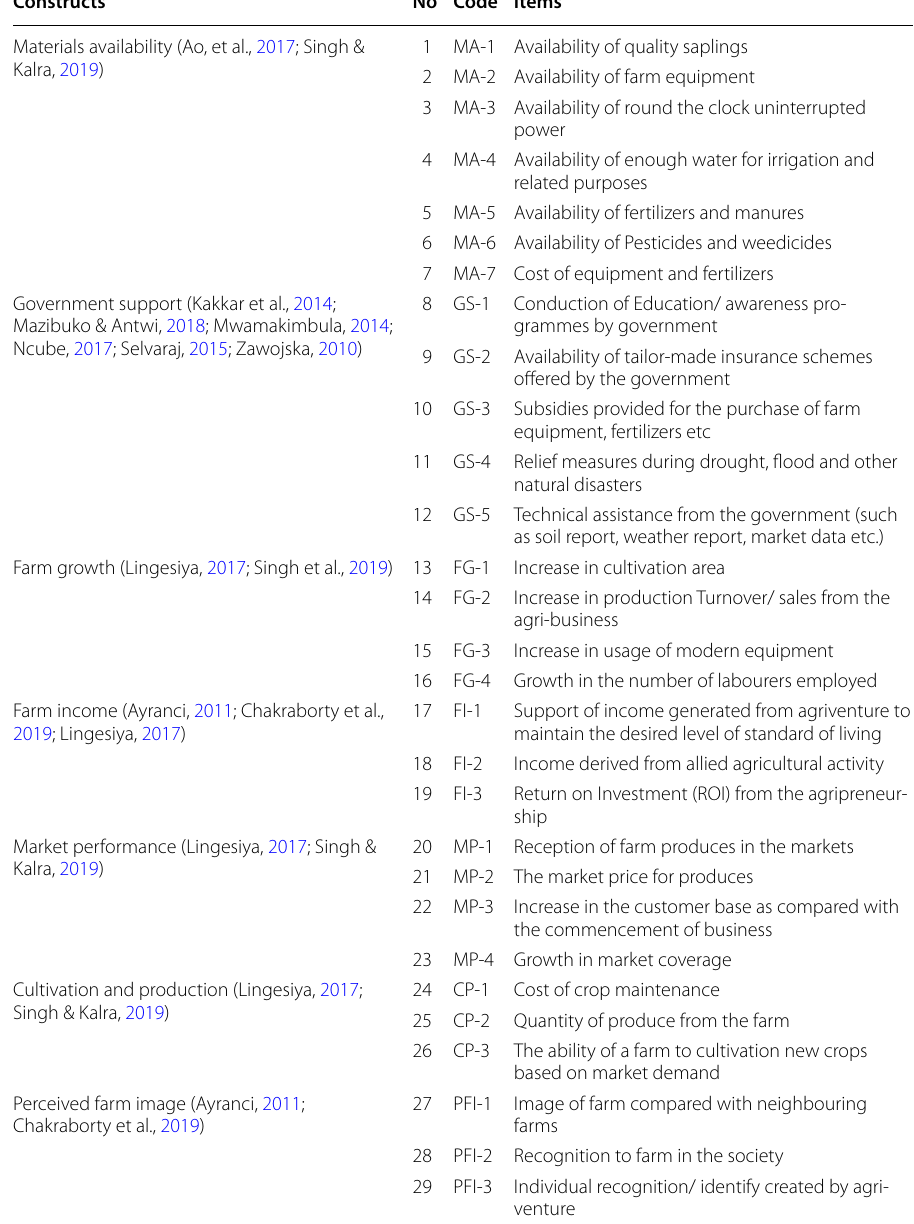
Table 1 Seven dimensions of AprenSAT and attributes of the study Constructs No Code